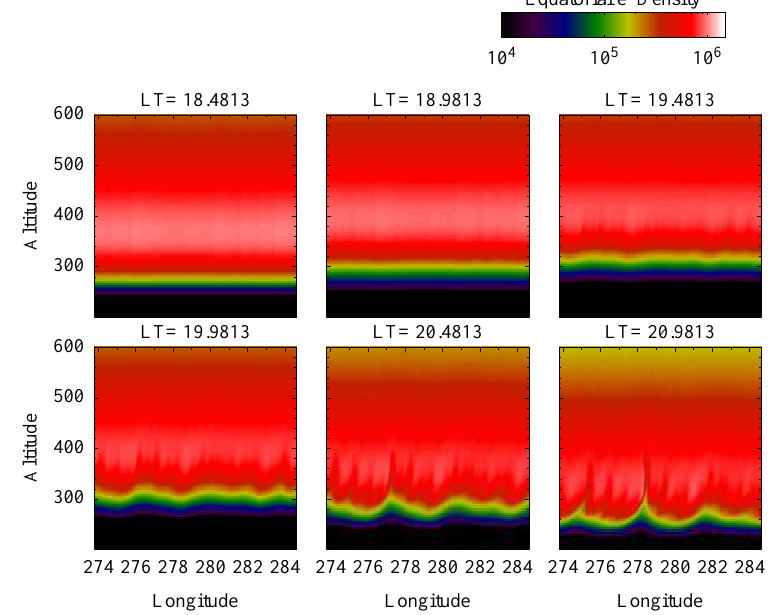
Fig. 13. Snapshots of the density taken at a sequence of times in a simulation in the plane of the geomagnetic equator as a function of longitude and apex altitude, beginning at the time of the density perturbations observed by the C/NOFS satellite around 23.8 UT on day 281 of 2010 near magnetic longitude 280 ◦ . (These density snapshots correspond to the density perturbations in Fig.